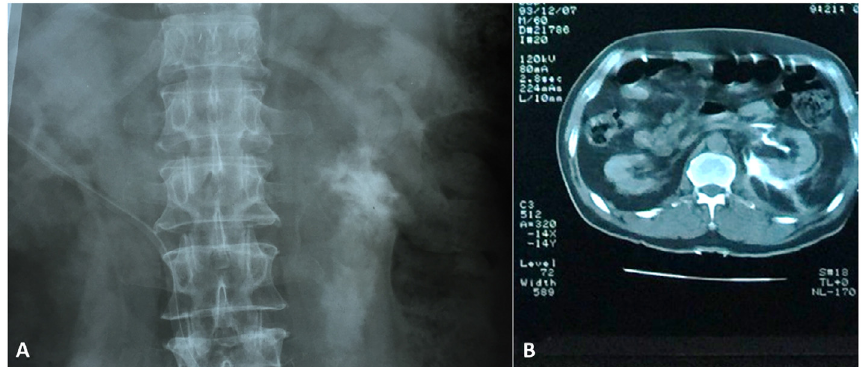
Figure 2. Intravenous pyelogram (A) and abdominal computed tomography (B) show fluid extravasation into the retroperitoneal space at the left side.